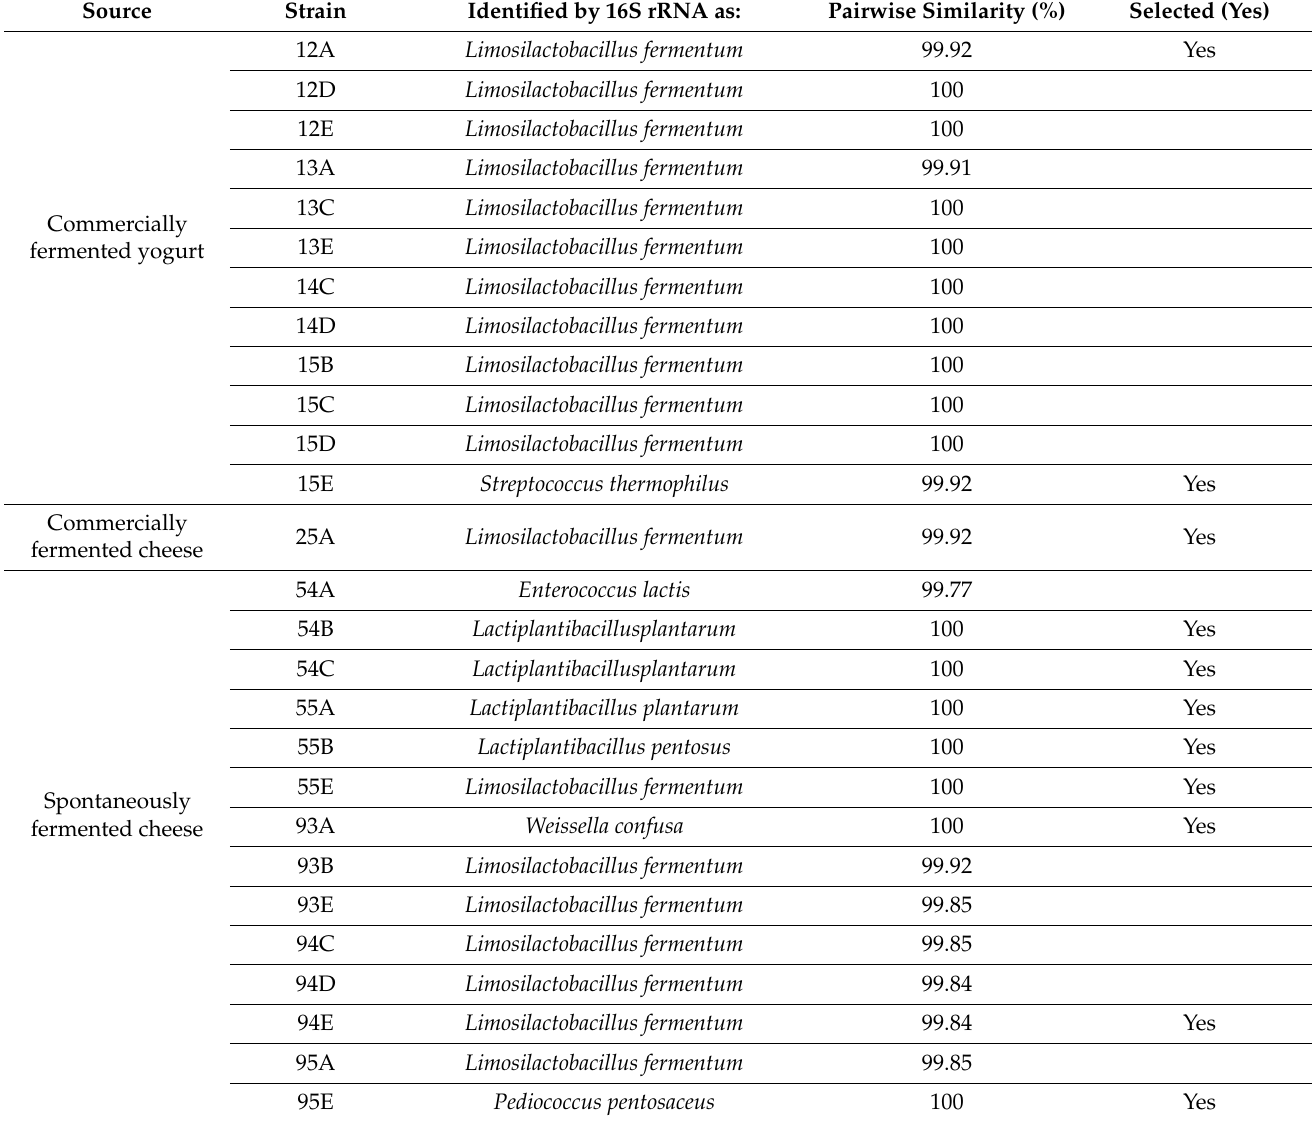
Table 1. 16S rRNA -gene-based identification of LAB isolates from Ethiopian dairy products. Source Strain Identified by 16S rRNA as: Pairwise Similarity (%) Selected